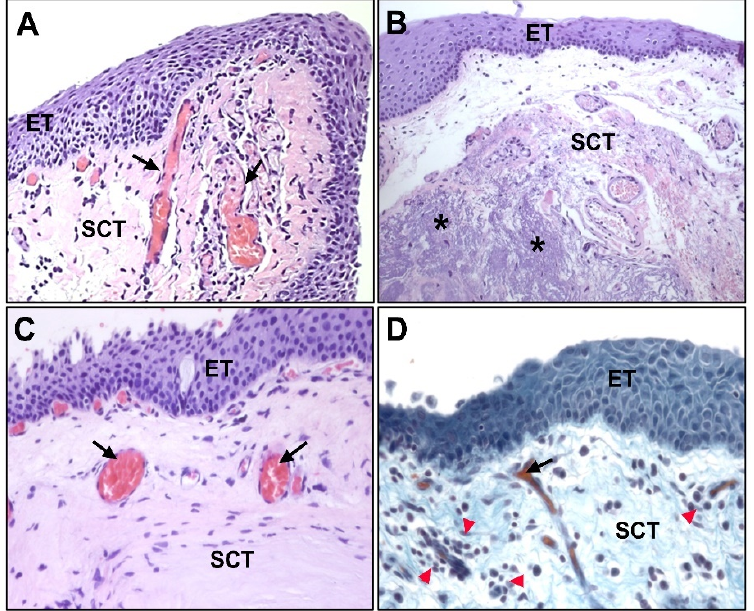
Figure 2. ( A ) Hematoxylin and eosin-stained image of healthy conjunctival tissue (×100); ( B ) amor- phous and fibrillar material (*) can be observed in the subepithelial zones of pterygium (×100); ( C ) no amorphous or fibrillar material can be observed in normal conjunctival tissue (×200); ( D ) presence of lymphocytic infiltrate ( ► ) near the vascular vessels in the subepithelial connective tissue of pterygium (×200). (ET, epithelial tissue; SCT, subepithelial connective tissue; → , blood vessels).